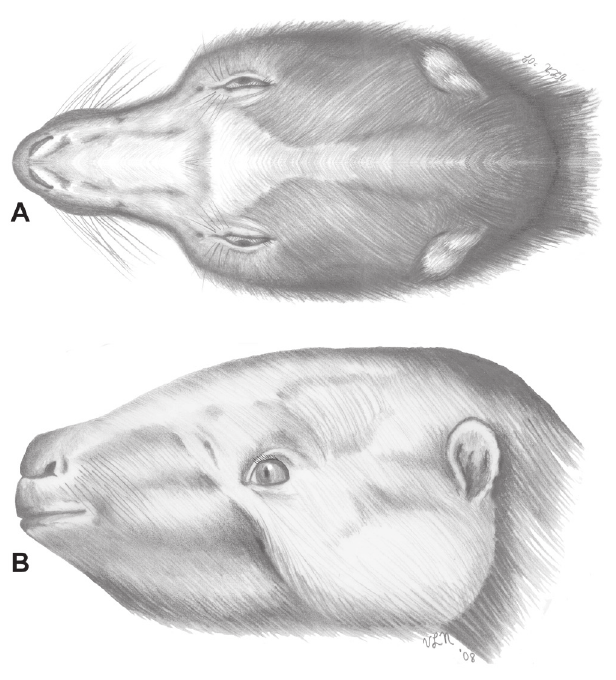
Figure 11. Reconstruction of the appearance of the head of Hapalops in dorsal view ( A ), showing the narrowness of the muzzle, and the much greater posterior width of the head, and in lateral view ( B ), showing the greatly elongated anterior portion of the cranium in this animal. This reconstruction results from new anatomical data generated in this